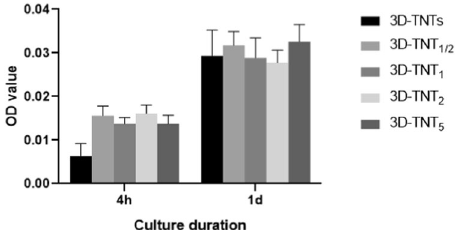
Fig. 8 CCK-8 assays for detecting the material toxicity to HGFs. HGFs growth assays on the 3D-TNTs, 3D-TNT 1/2 , 3D-TNT 1 , 3D- TNT 2 and 3D-TNT 5 after incubation for 4 h and 1day